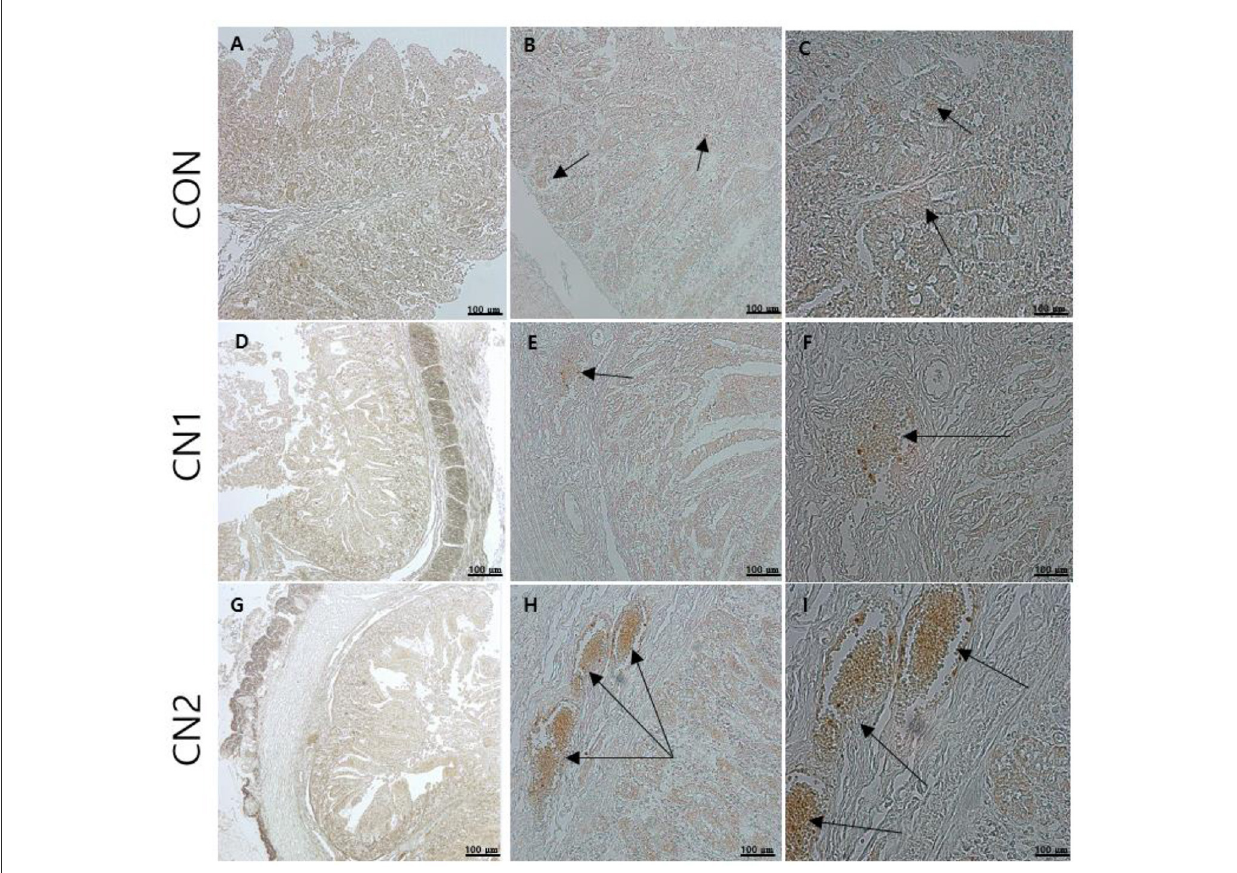
FIGURE4 The immunohistochemical slides for the expressions of claudin 3 (CD3) collected from the jejunal sections of small intestine ( n = 6) in growing to finishing pigs fed (A–C) the control (CON) diet wihout curcumin nanospheres (CN); (D–F) the control diet supplemented with CN at 1.0 ml/kg diet (CN1); (G–I) the control diet supplemented with CN at 2.0 ml/kg diet (CN1); The arrow heads represents the intensity of expressions of CD3 as the tight junction protein. Tissue sections were stained with 3,3’-diaminobenzidine (DAB) viewing using bars 100 µ m at different